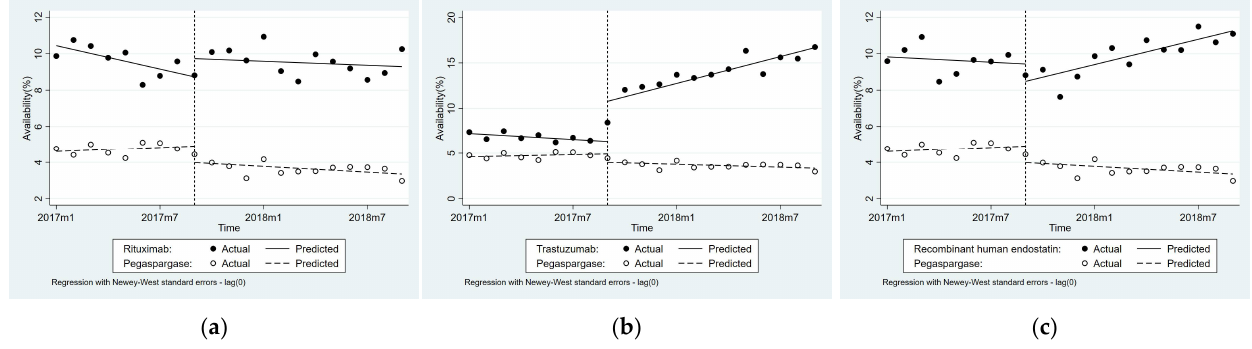
Figure 3. Availability of three targeted anticancer drugs: ( a ) Rituximab; ( b ) Trastuzumab; ( c ) Recombinant human endostatin.